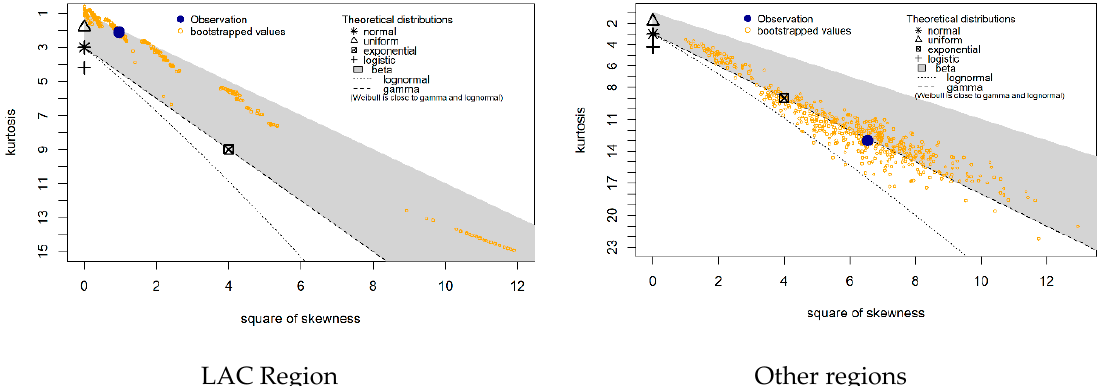
Figure 4. Cullen and Frey graph of the SJR of journals from LAC and other regions.